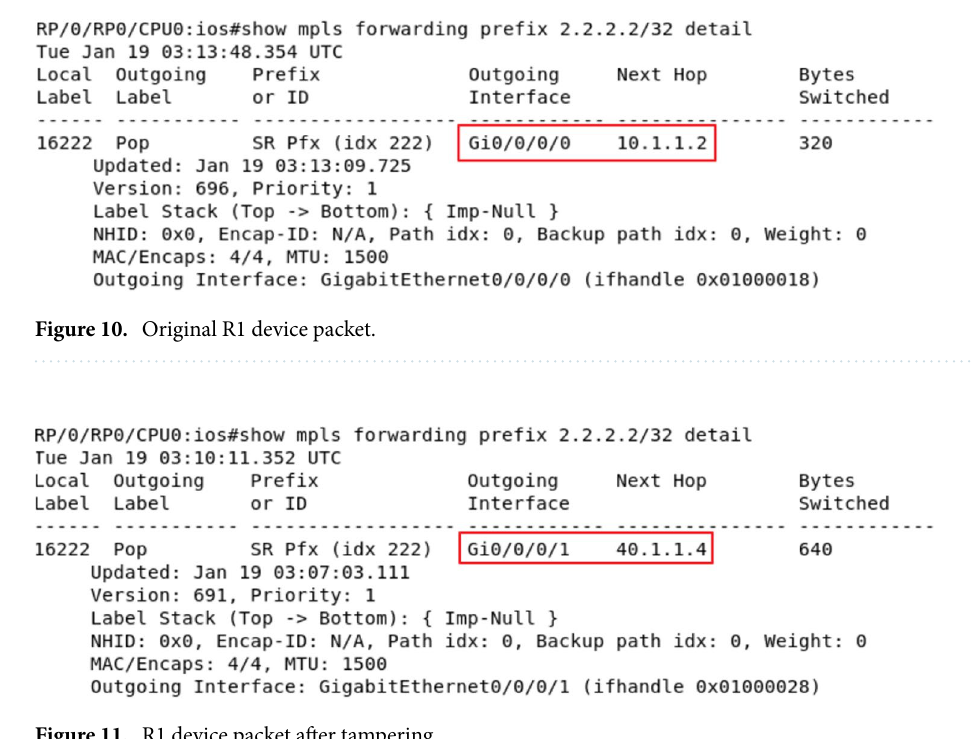
Figure 11. R1 device packet after